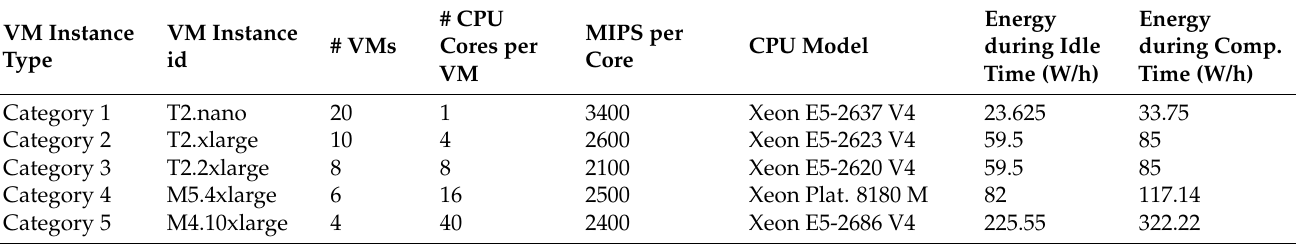
Table 6. Description of the VM